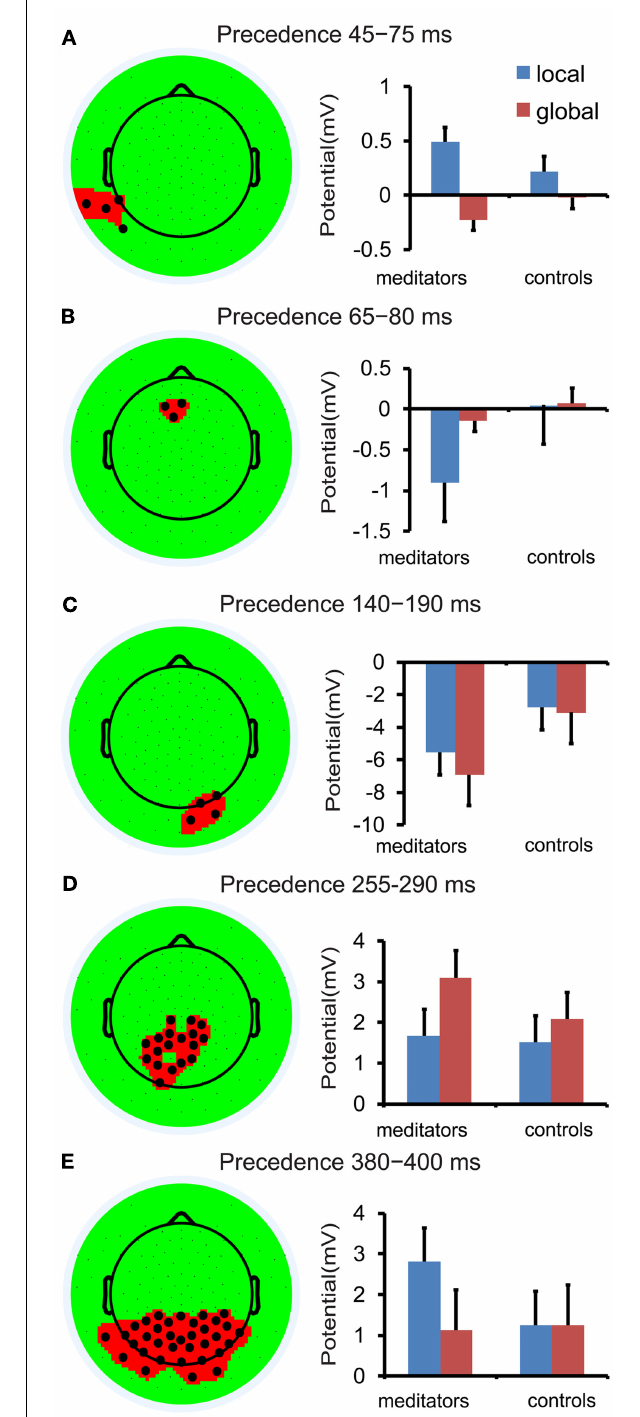
FIGURE 7 | Data-driven analysis based on precedence mapping. Each head plot shows the electrodes exhibiting an effect of precedence averaged over the corresponding time period. Each panel, (A–E) , shows the amplitude difference between local and global targets (local–global) averaged over the corresponding time period and electrodes. Meditators are shown in red, controls in blue. Error bars represent the